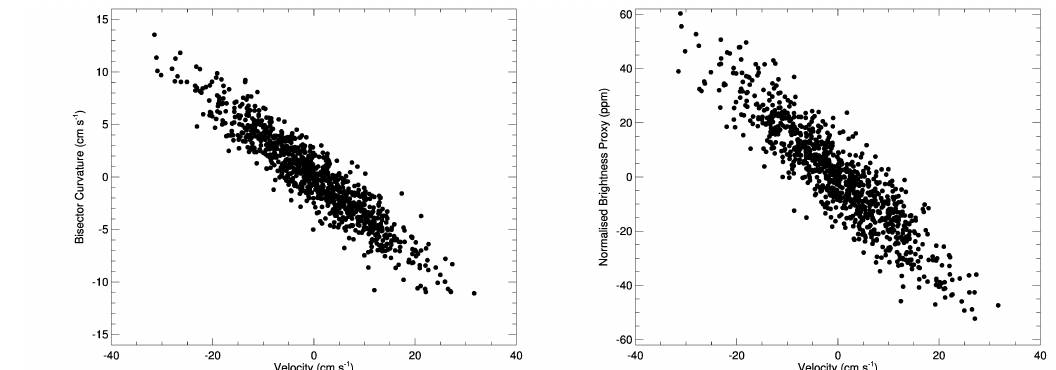
Figure 10. The (mean-subtracted) bisector curvature (left) and normalized brightness proxy (right) as a function of granulation-induced RV for the Fe I 6302 line from the model star simulations of [90]; the brightness was approximated by integrating the area under the line profile. A strong linear correlation is clearly discernible but would require the next generation of spectrographs and space-based photometric missions to be empirically